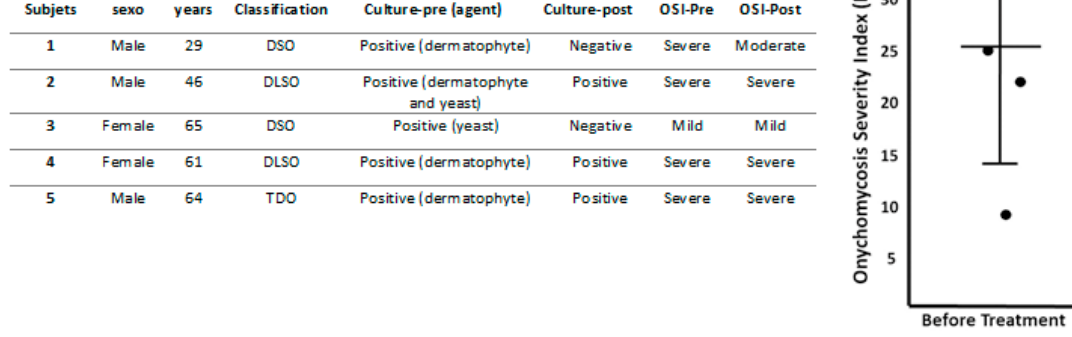
Figure 2. Detailed results by participants ( A ) and representation of evolution based on the points OSI ( B ). ** p-value = 0.011 .